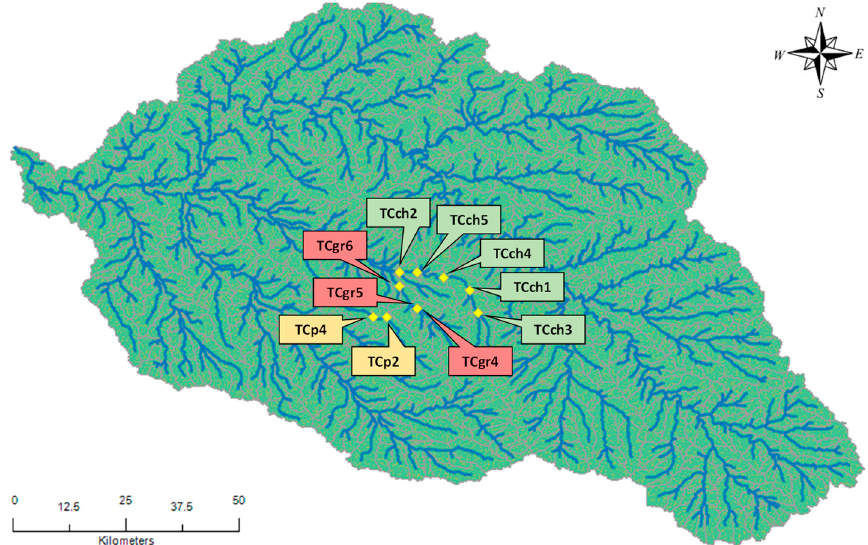
Figure 9. The selected ten possible sites for building reservoir in the Uruguayan side of the transboundary watershed.